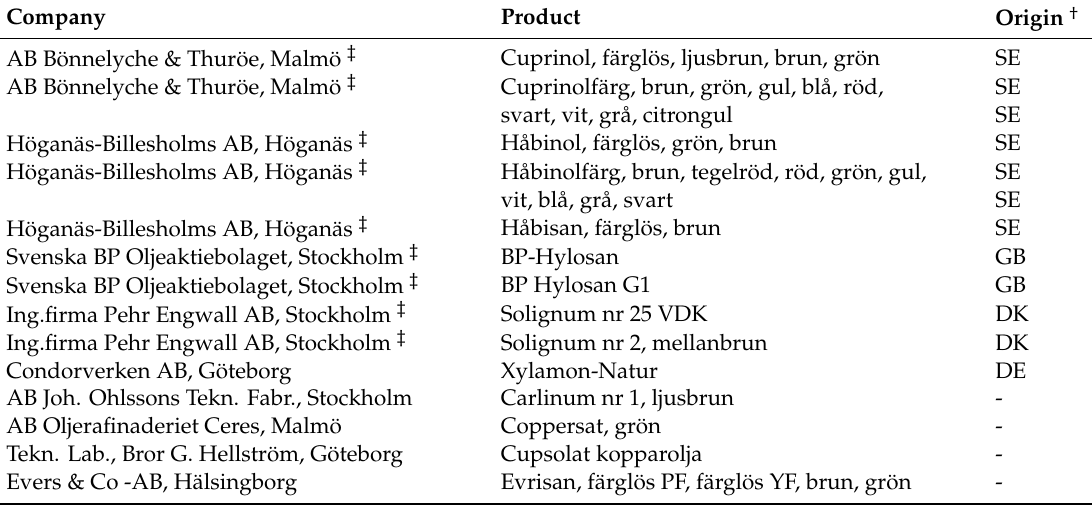
Table A1. Products with preservatives that were approved for use in buildings and outdoors by Statens Provningsanstalt (SP) in 1960. The products were intended for brushing, dipping and